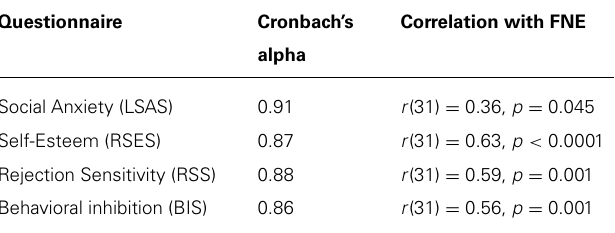
Table 2 | Internal consistencies of the questionnaires used to index social anxiety, self-esteem, rejection sensitivity, and behavioral